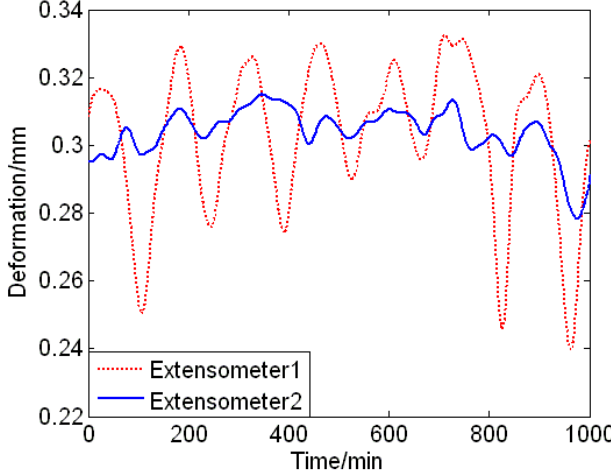
Figure 8. Original data from two extensometers with different fixation